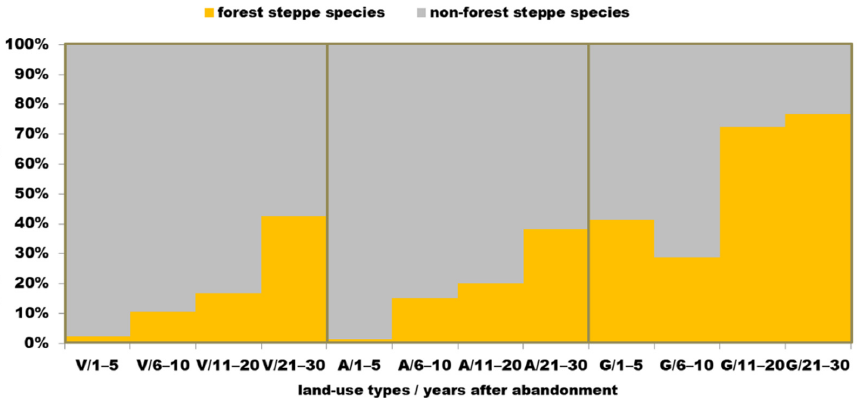
Figure 3. Changes in the relative proportion of average total cover of forest steppe species in dif ‐ ferent age groups of abandoned lands (V—vineyards, A—arable land, G—grasslands).